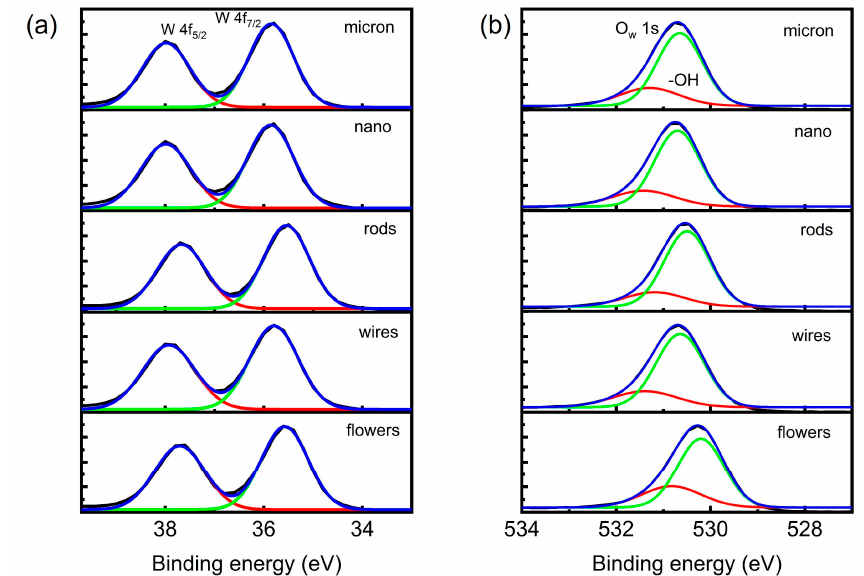
Figure 3. XPS spectra of ( a ) W 4f and ( b ) O 1s for all the WO 3